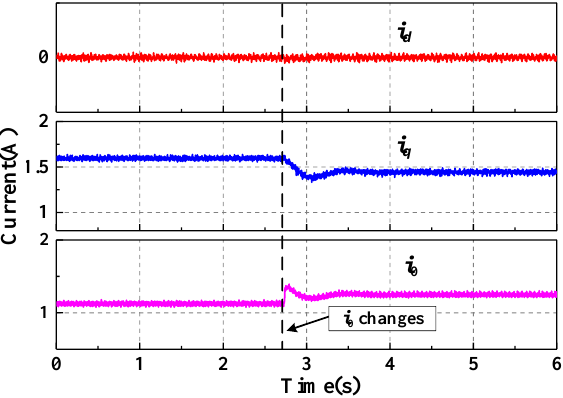
Figure 11. Results of parameter identification (nonlinearity compensation). The inverter nonlinearity can also be affected by i 0 and AC component ratio. A step increase of i 0 is implemented in the experiment to analyze this problem. Since the load torque remains unchanged, i q decreases accordingly. Thus, the ratio between i 0 and the AC component becomes larger. Figure 12 shows the i d , i q , i 0 , where i d is 0. At about 2.7 s, i 0 increases.